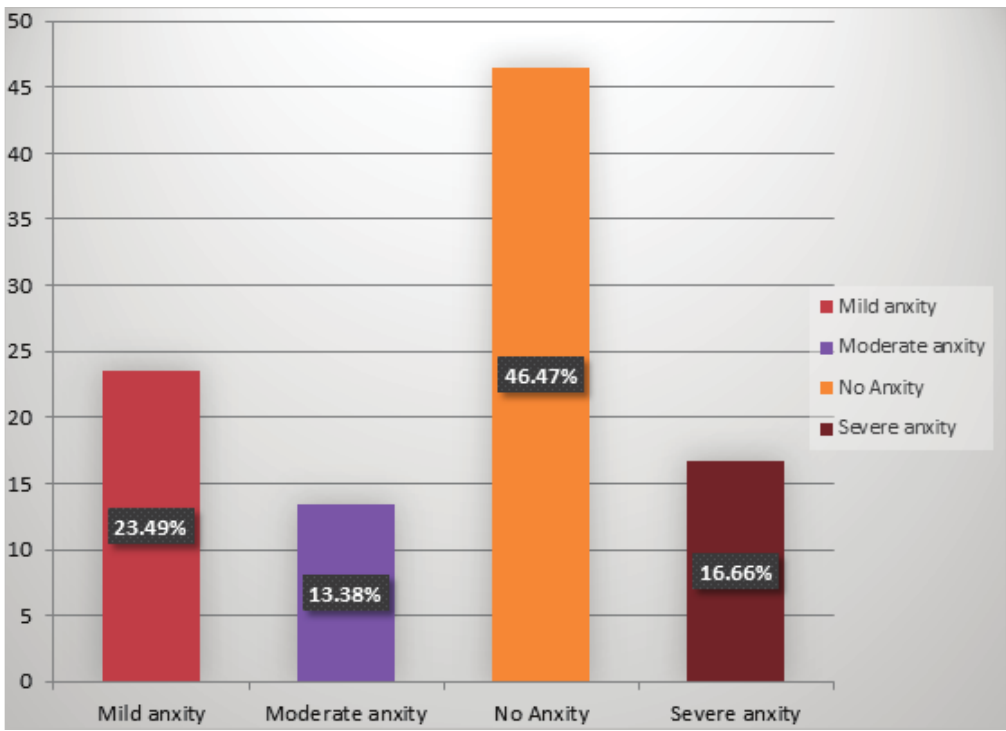
Figure 2: GAD-7 Score among